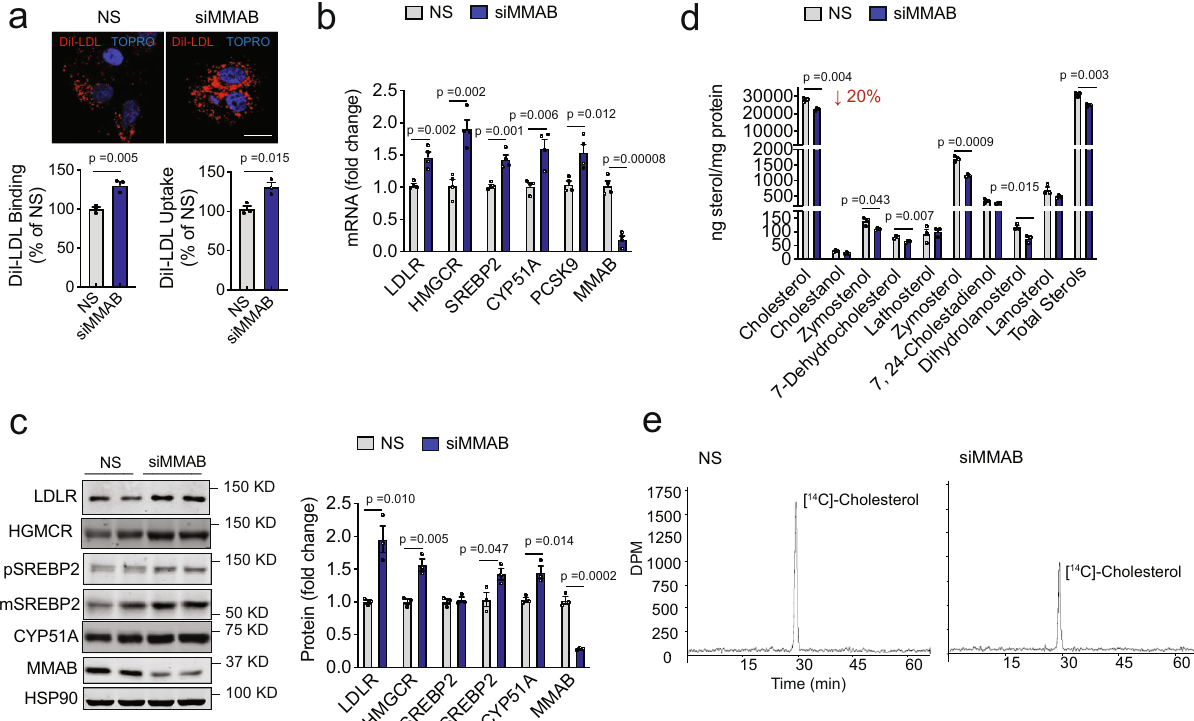
Fig. 4 Knockdown of MMAB increases LDLR expression and activity and decreases cholesterol biosynthesis in vitro. a Representative images of DiI- LDL uptake in Huh7 cells transfected with a non-silencing siRNA (NS) or siRNA MMAB (siMMAB) and incubated with 30 μ g/ml DiI-LDL for 8 h at 37 °C. Red, DiI-LDL; blue, nuclei stained with TO-PRO-3 iodide (TOPRO). Scale bar, 10 μ m. Flow cytometry analysis of DiI-LDL speci fi c binding and uptake in Huh7 cells transfected with NS siRNA or siMMAB and incubated with 30 μ g/ml DiI-LDL for 8 h at 37 °C (uptake) or 90 min at 4 °C (binding) is shown below. Data are mean ± s.e.m. of three independent experiments. Statistical comparisons by two-sided unpaired Student ’ s t test. b , c qRT-PCR ( b ) and Western analysis ( c ) of SREBP2-responsive genes in Huh7 cells transfected with an NS control siRNA or siMMAB. HSP90 was used as a loading control. Quanti fi cation compared to HSP90 is shown in panel ( c ). Data are mean ± s.e.m. of three ( c ) or four ( b ) independent experiments in duplicate. Statistical comparisons by two-sided unpaired Student ’ s t test. d Sterol content of Huh7 cells transfected with NS siRNA or siMMAB. Lipids were extracted and analyzed by GC-MS. “ Total sterols ” were calculated as the sum of all sterols that could be detected. Data are mean ± s.e.m. of three independent experiments. Statistical comparisons by two-sided unpaired Student ’ s t test. e Effect of MMAB knockdown on [1,2- 14 C]-acetate incorporation into cholesterol as determined by HPLC. Huh7 cells were treated as in ( d ). Data are representative of three independent experiments. Source data are provided as a Source Data fi